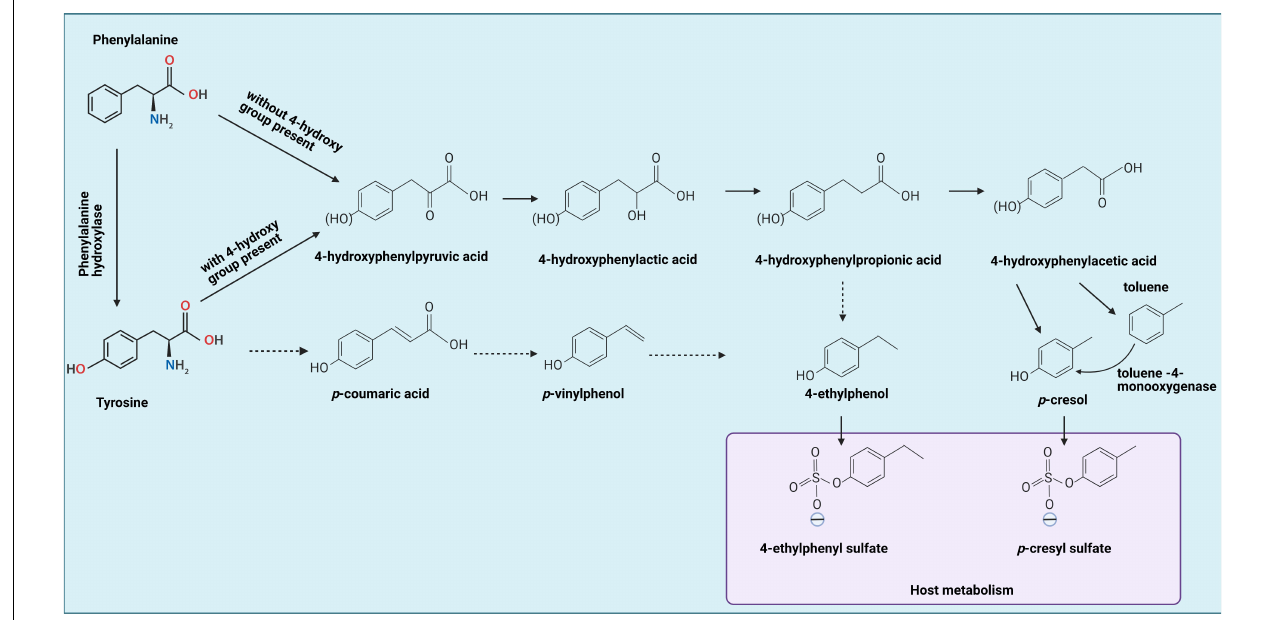
FIGURE 1 | Tyrosine by gut bacteria leading to formation of 4-ethylphenol and p -cresol, which can be metabolized by the host into 4-ethylphenyl sulfate and p -cresol sulfate, respectively, indicated by the blue box. Solid lines represent established reactions, dotted lines represent presumed reactions taking place. Phenylalanine metabolism occurs similarly, but without the 4-hydroxy group present. In addition, phenylalanine can be converted to tyrosine first, then goes through same procedures with tyrosine metabolism. This figure is adapted from Hsiao et al. (2013), Smith and Macfarlane (1996), and Schuck et al.